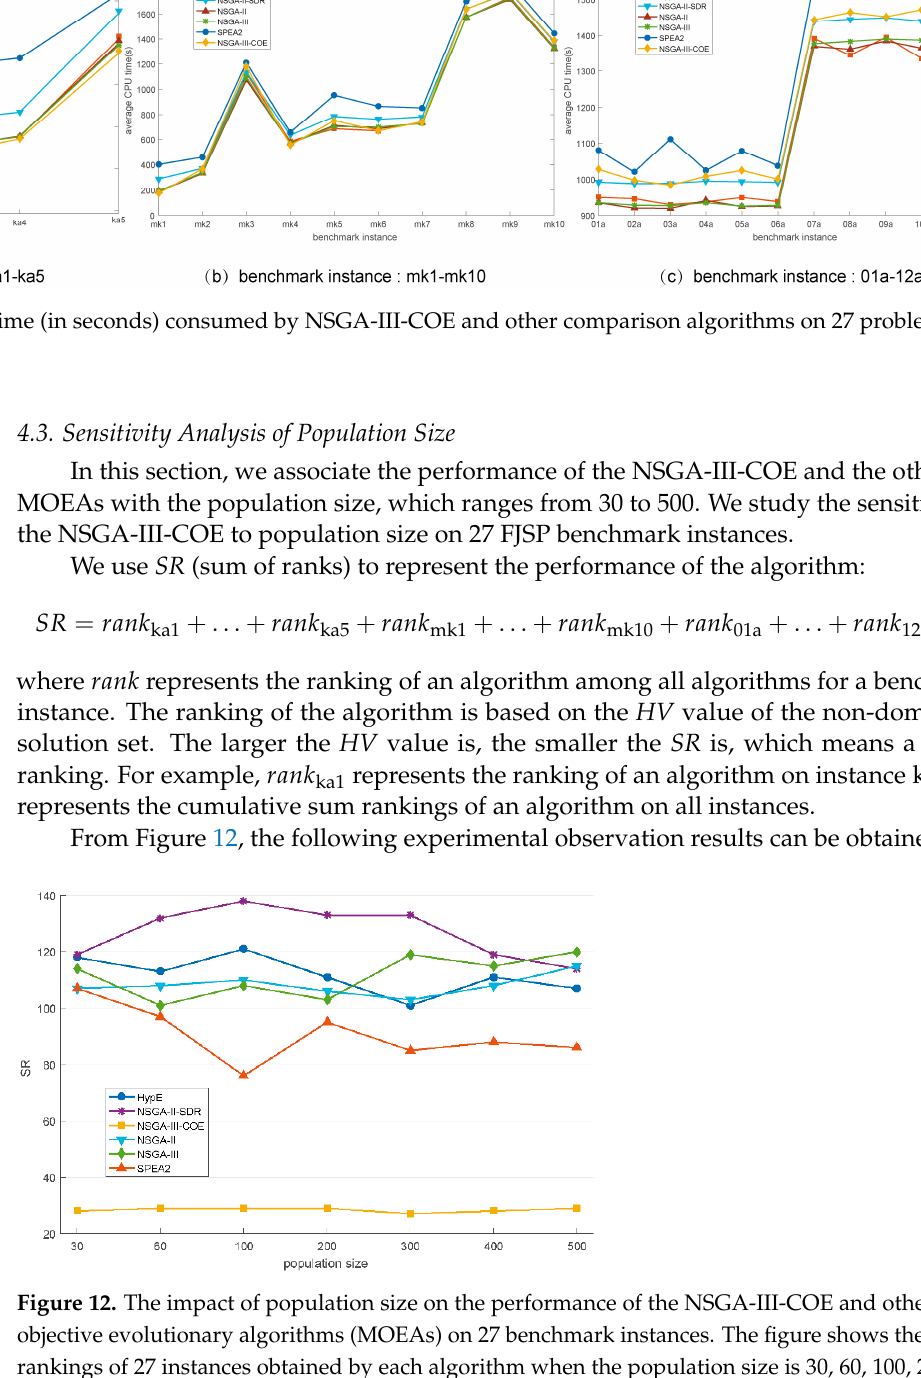
Figure 11. Average CPU time (in seconds) consumed by NSGA-III-COE and other comparison algorithms on 27 problem instances.